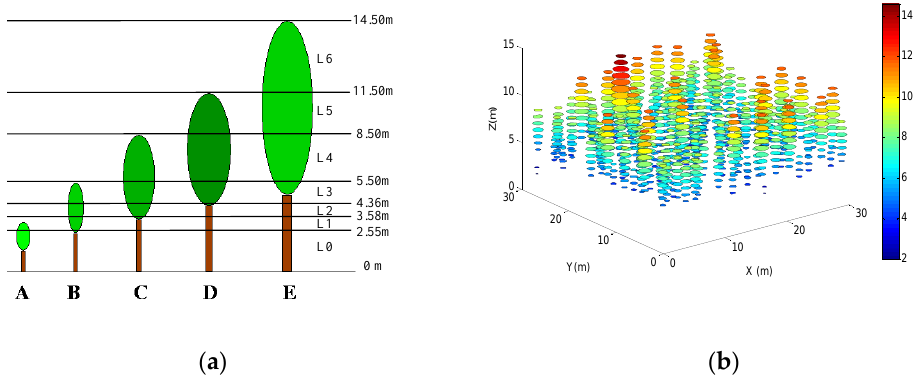
Figure 12. HET05 scene: ( a ) five tree classes divided into seven regions (L0 to L6); ( b ) 20 HETOBJs containing many HOMOBJs (circles); colors from blue to red represent heights from 2.5 m to 14.5 m.